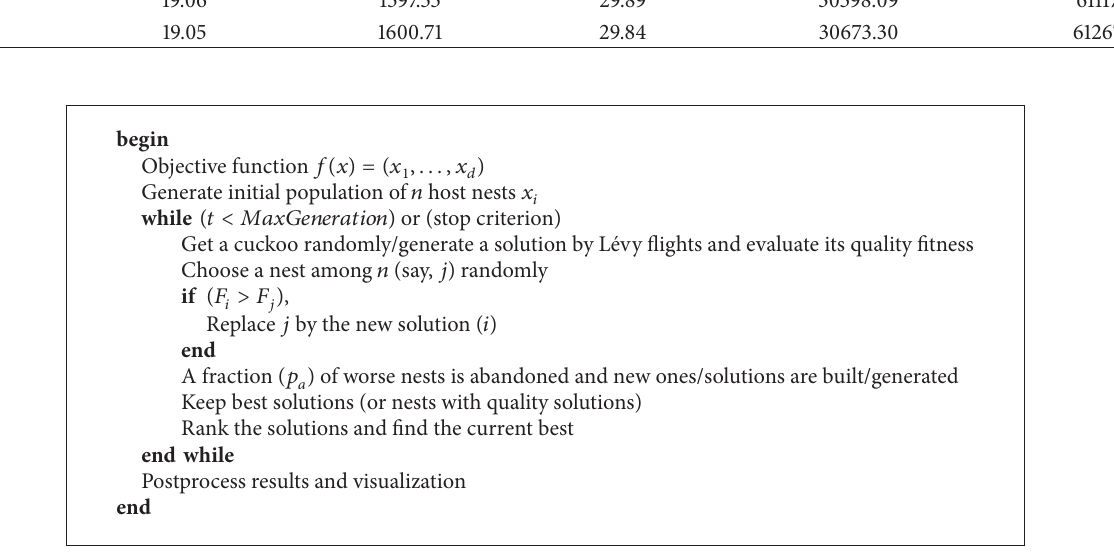
Algorithm 1: The pseudocode of the applied cuckoo search